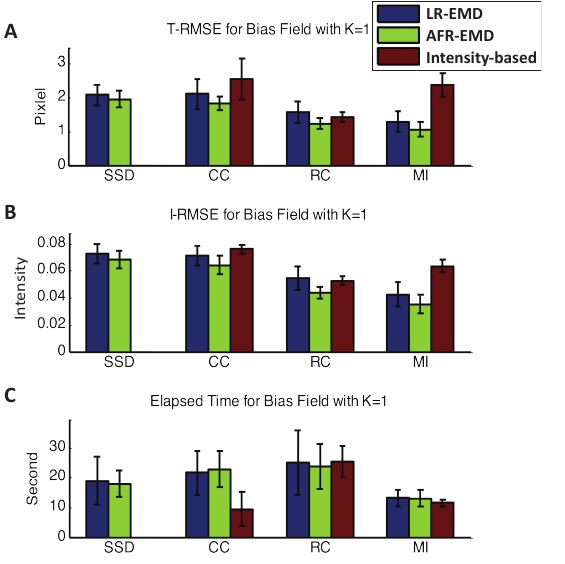
Figure 5. Registration performance in the presence of one Gaussian kernel. Mean and variance of T-RMSE and I-RMSE for images in BrainWeb dataset are shown in ( A , B ) panels. ( C ) panel compares the running time for all methods.